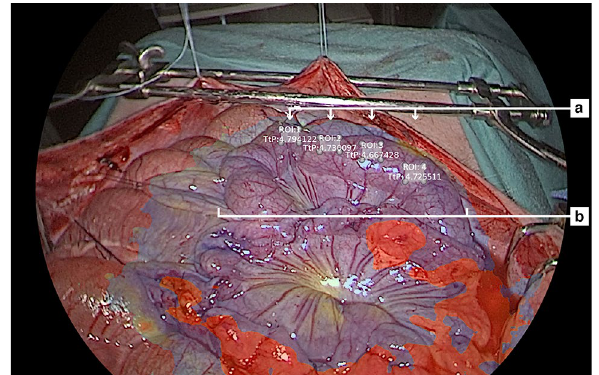
Figure 1. Study set-up with fluorescence-based enhanced reality (FLER) overlay. ( a) Randomly chosen regions of interest (ROIs) and ( b) small intestine parts under